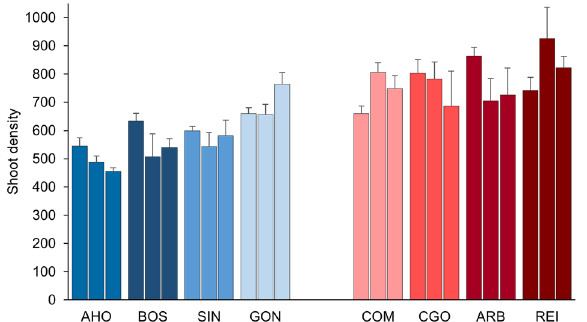
Figure 1. Posidonia oceanica mean (+ SE) shoot density (# of shoots/m 2 ) at each location: in blue the western and in red the eastern. For each location data of the three areas are shown (n =